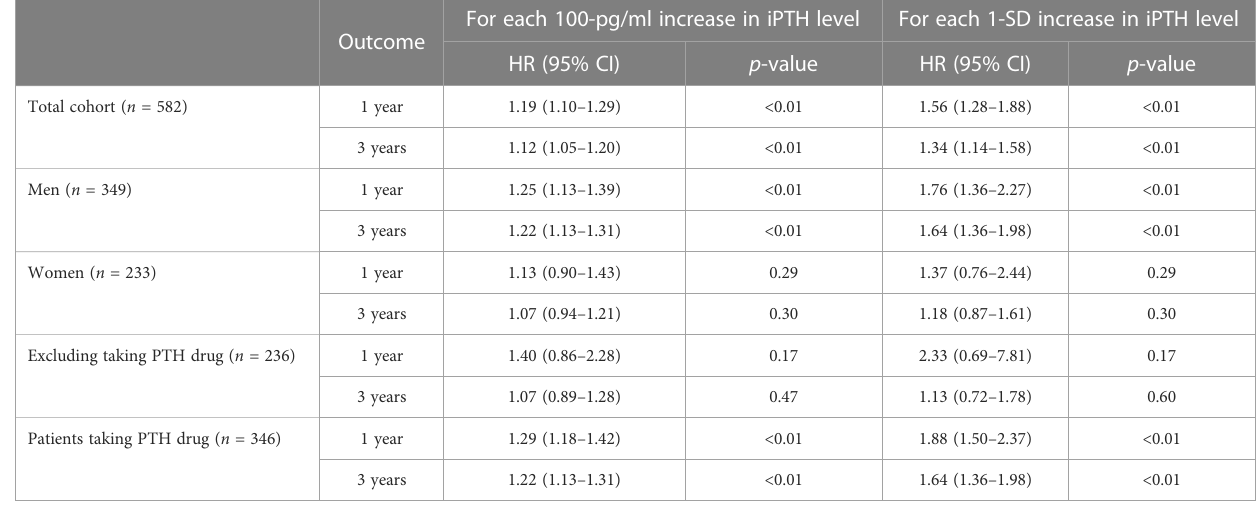
TABLE 5 First peritonitis episode for each 100-pg/ml and 1-SD increase in the serum intact parathyroid hormone (iPTH) level. For each 100-pg/ml increase in iPTH level For each 1-SD increase in iPTH Outcome